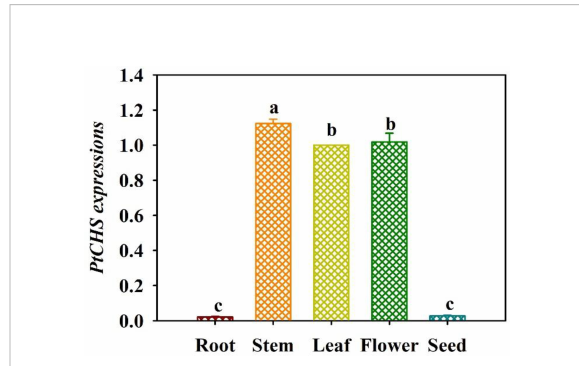
FIGURE 4 Tissue-speci fi c expressions of PtCHS in trifoliate orange. Data (means ± SD, n = 4) followed by different letters above the bars indicate signi fi cant ( P < 0.05) differences.